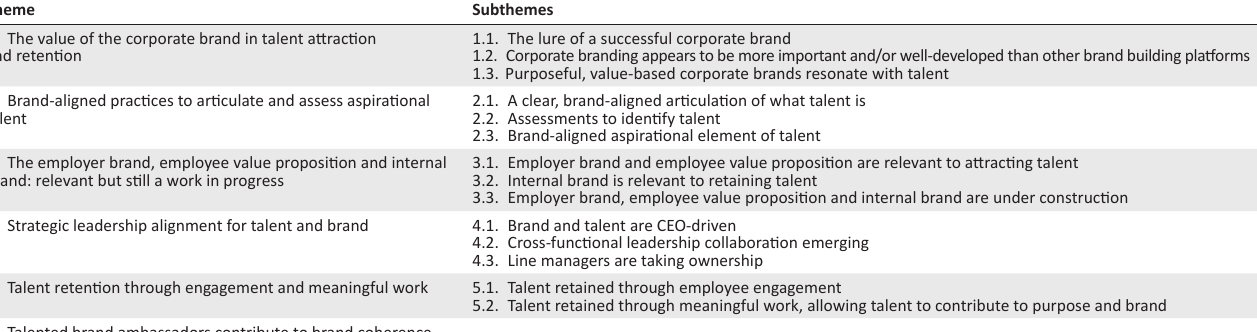
TABLE 2: Themes and